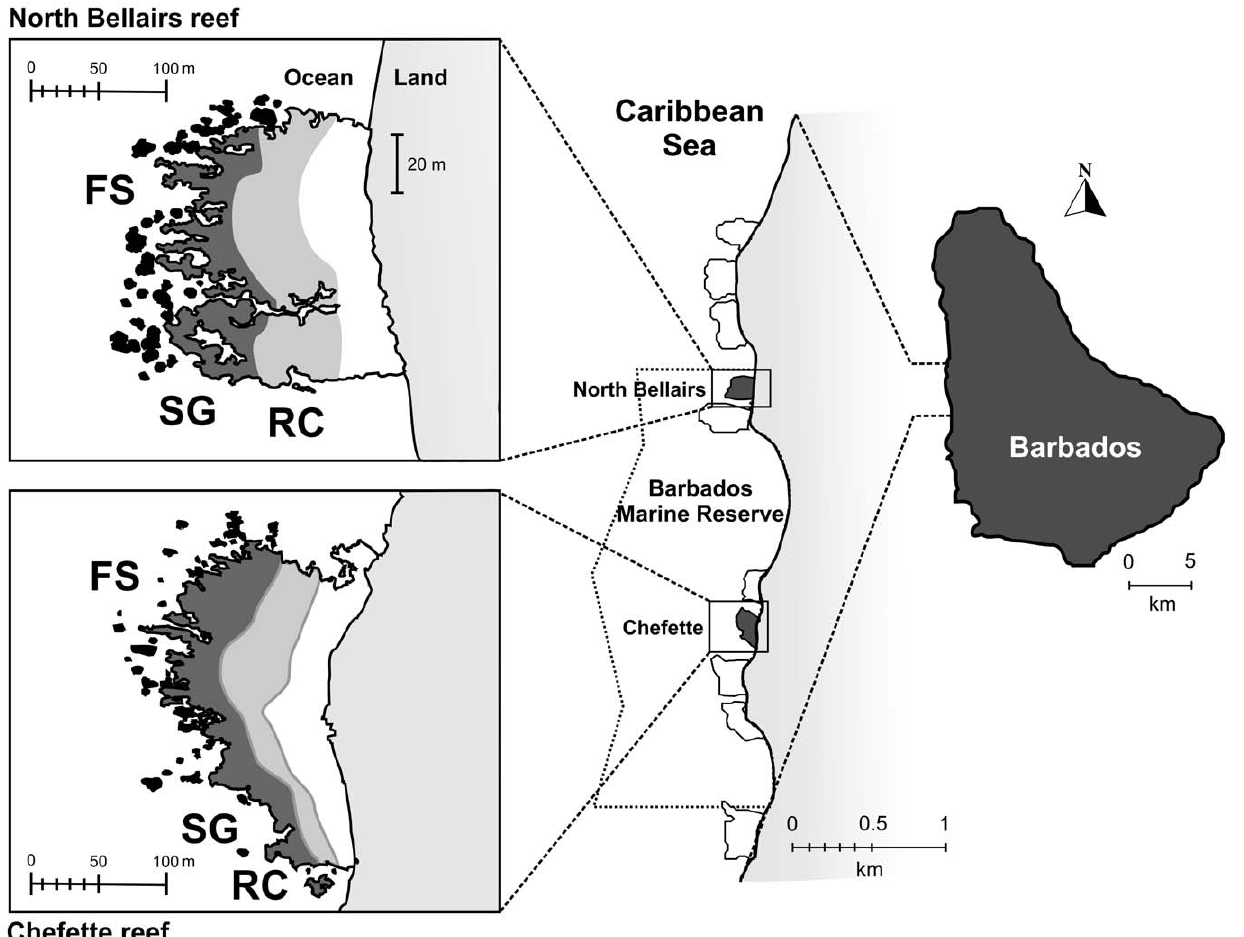
Figure 1. Schematic representation of the two study reefs on the west coast of Barbados, West Indies. The three reef zones examined are indicated as follows: reef crest (RC, light grey), spur and groove (SG, dark grey), and fragmented spurs (FS, black). The back reef (white), located inshore of the reef crest, was not sampled in this study. The Barbados Marine Reserve is indicated by the dotted polygon.